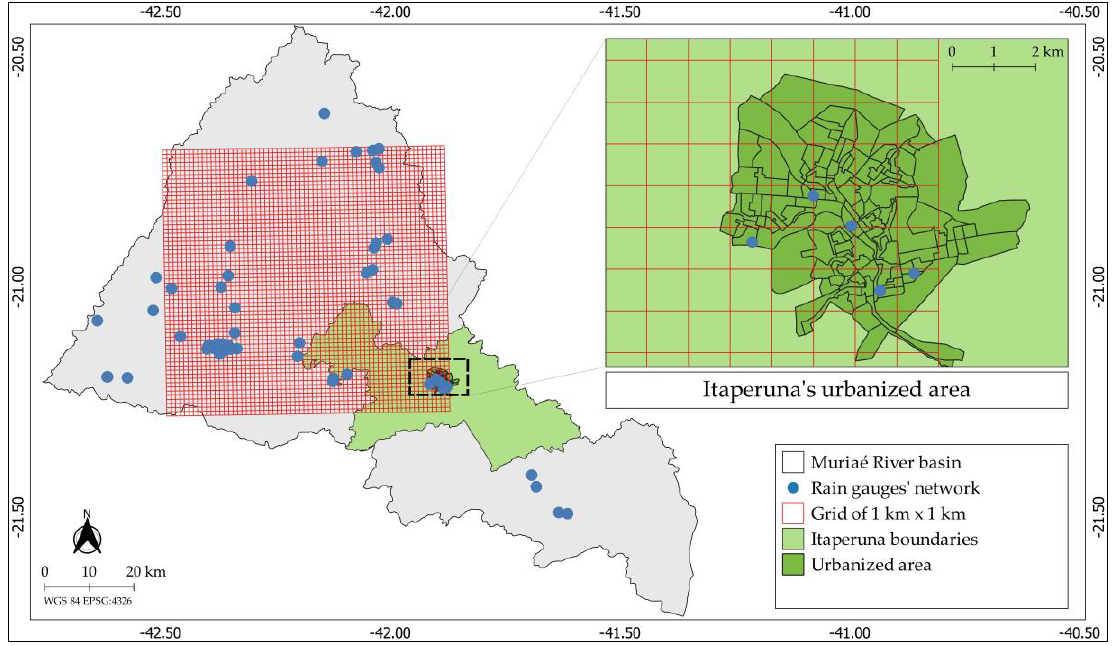
Figure 10. Muriaé River basin and the municipality of Itaperuna locations, rain gauges’ distribution (blue dots), and the 64 km × 64 km selected area with a grid size of 1 km × 1 km.